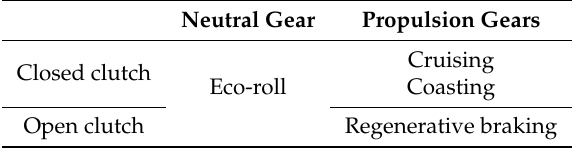
Table 1. Possible driving modes per state of mechanical clutch and engaged transmission